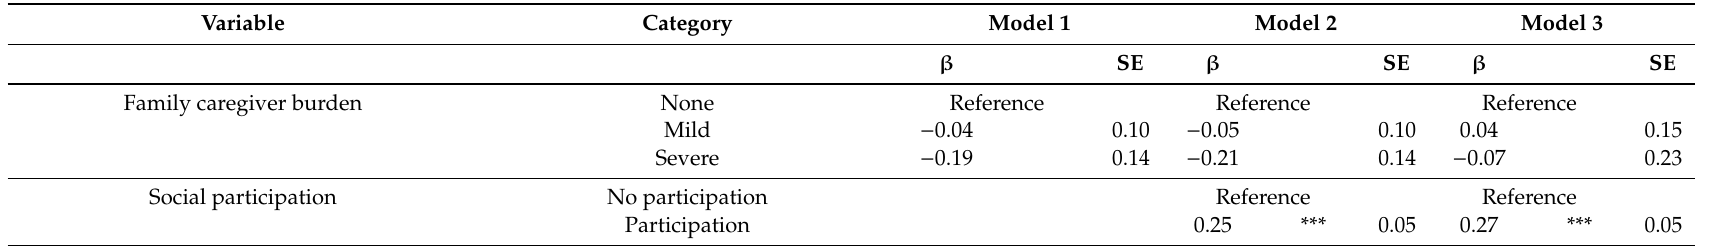
Table 2. The association between family caregiver burden and subjective well-being, multivariable linear regression analysis